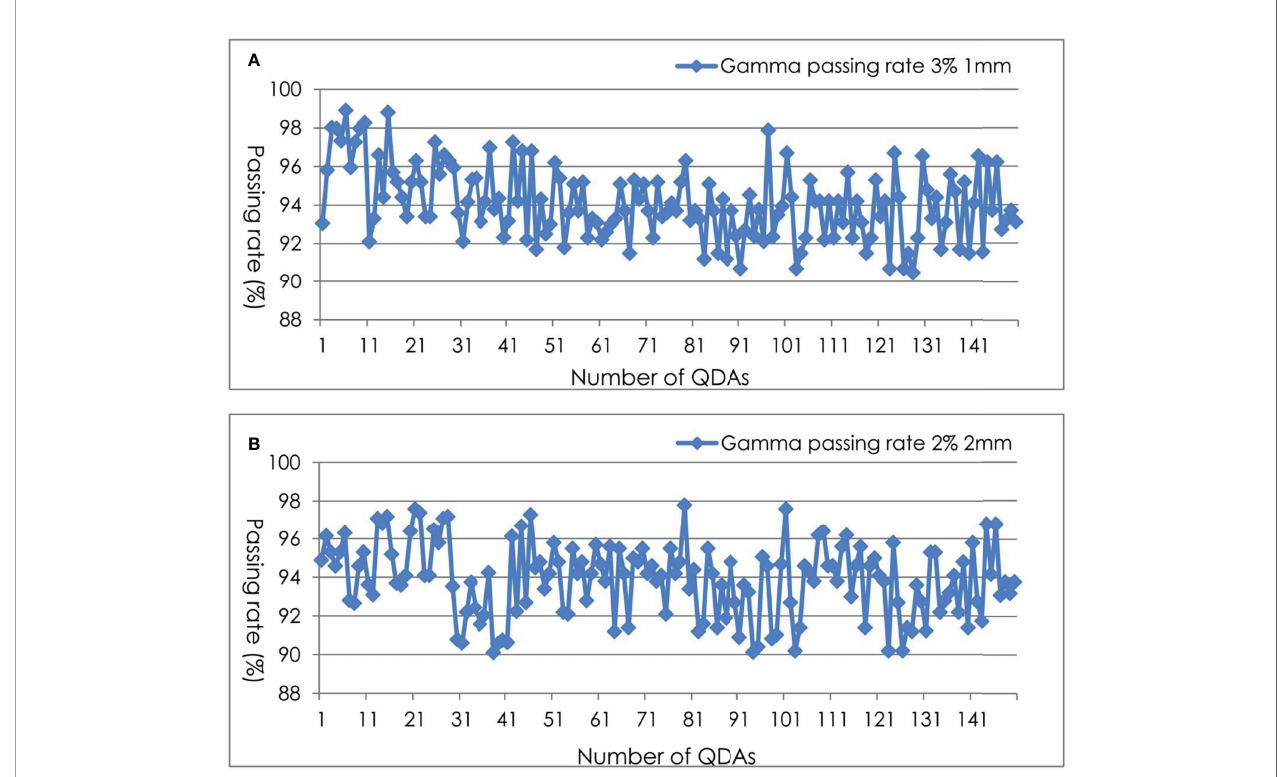
FIGURE 3 | Gamma passing rate for fi lm-based Cyberknife DQAs at 3%/1mm (A) , 2%/2 mm (B) .